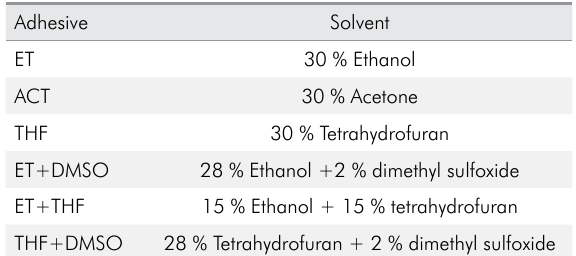
Table 1. Detailed information of solvent contents in different adhesive